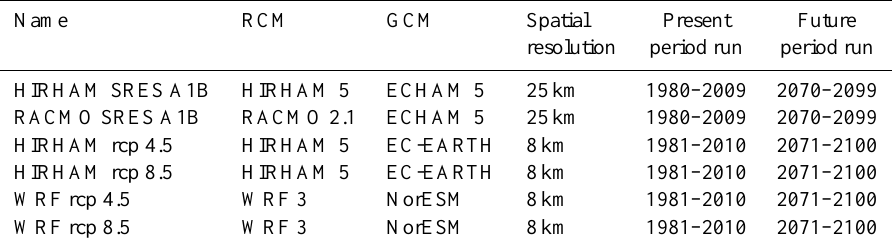
Table 2. Regional climate model (RCM) runs from which precipitation output is used to calculate perturbations schemes for the WG used in this study. All have a temporal resolution of 1h. RCM